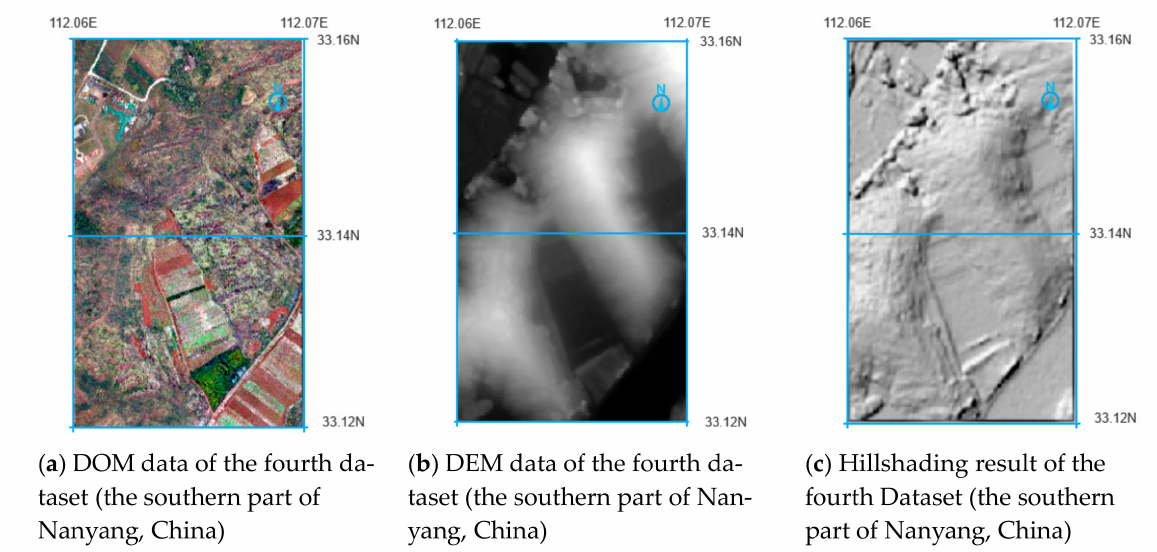
Figure 20. The fourth dataset: ( a ) DOM data of the fourth dataset (the southern part of Nanyang, China); ( b ) DEM data of the fourth dataset (the southern part of Nanyang, China); ( c ) Hillshading result of the fourth dataset (the southern part of the Nanyang,